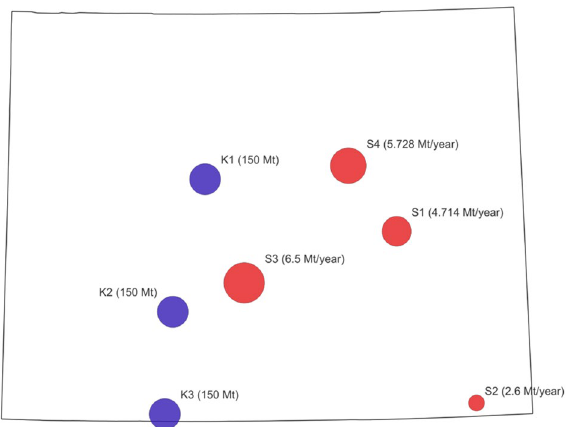
Figure 3. A map of CO 2 sources and sinks for the Wyoming case study. The blue circle indicates the location of each sink while the size indicates the storage capacity in Mt CO 2 ; the red circle denotes the location of each CO 2 point source while the size indicates the capture amount in Mt/year.